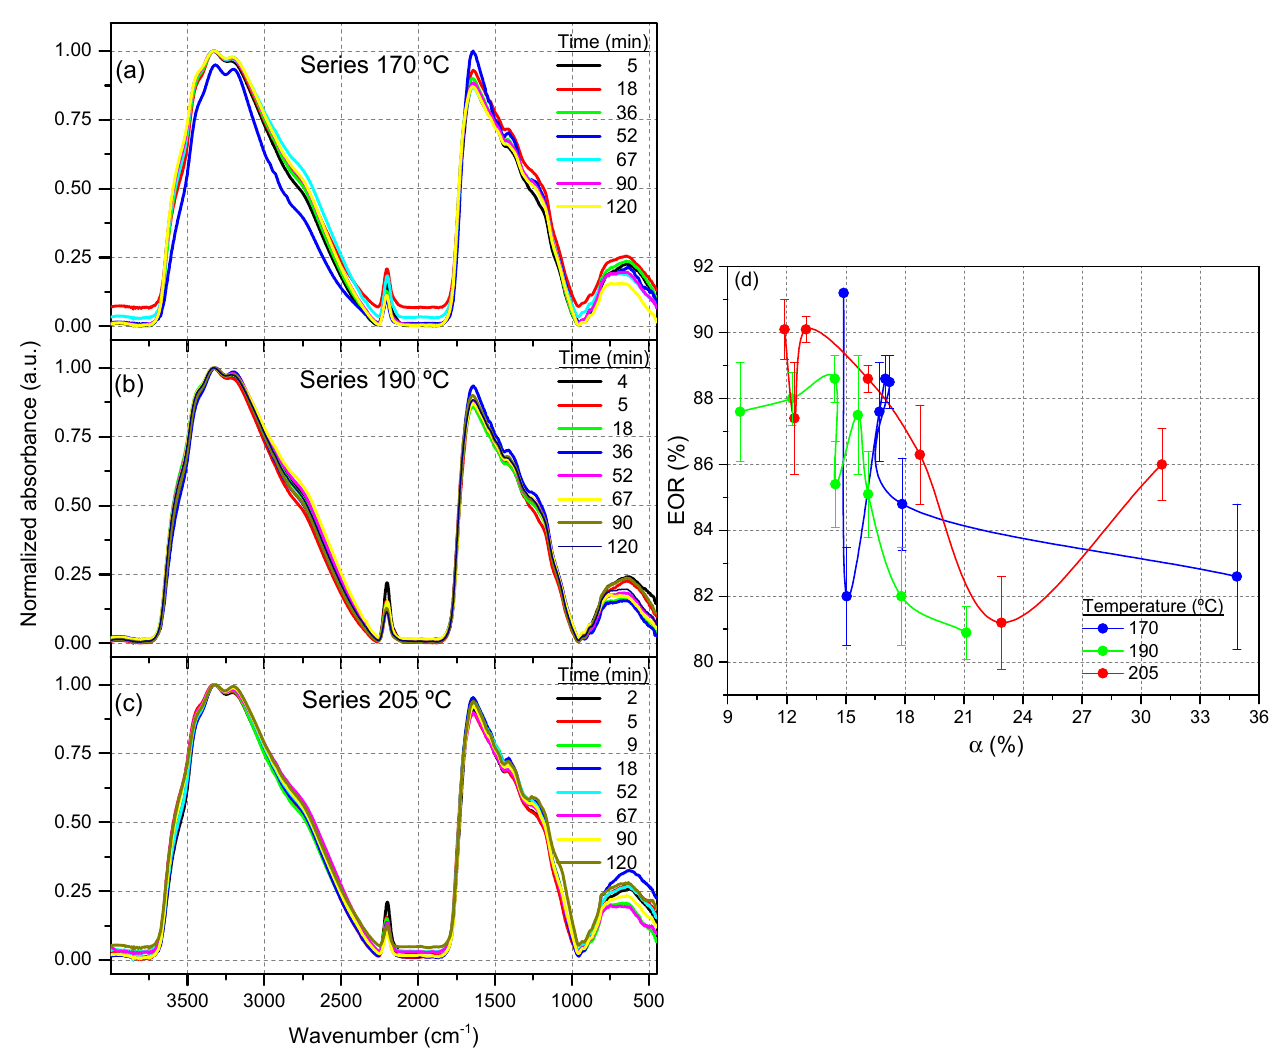
Figure 3. ( a – c ) Representative FT-IR spectra of NH 4 CN polymers synthesized at the indicated temperatures and using the shown reaction times in each graph, by assisted MWR to reach the corresponding temperature and from equimolar water solutions of NaCN and NH 4 Cl (1 M). ( d ) Values of EOR (%) vs. conversion degree for cyanide polymers synthesized at the temperatures indicated in the legend using MWR. The average EOR (%) values were calculated from the data shown in Table